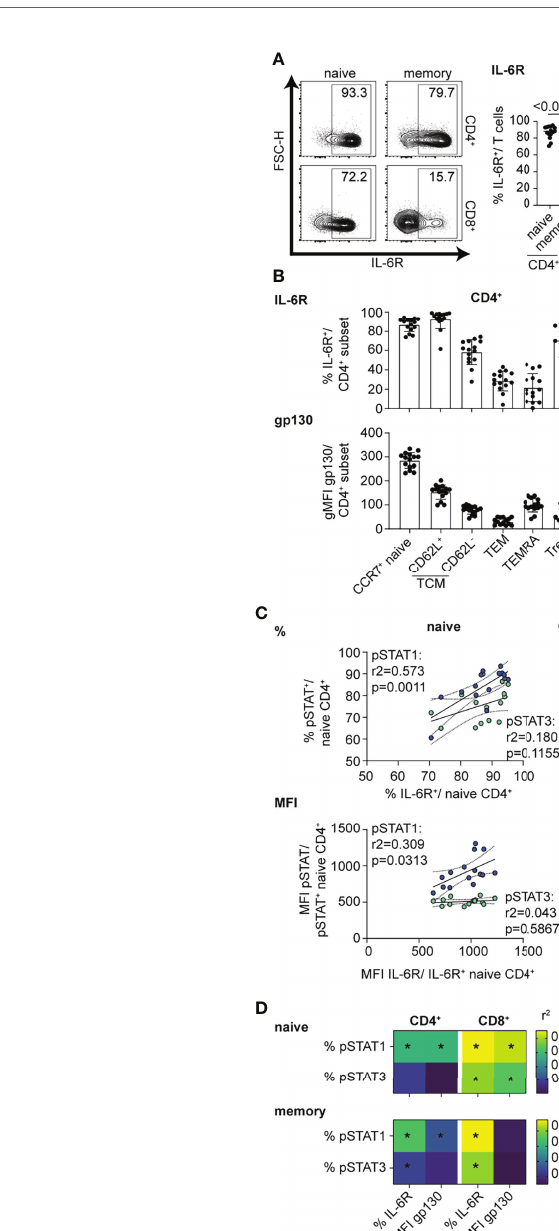
re fl ected in the transcriptome signature. We performed RNA-seq on sorted CD4 + naïve and memory T cells, as well as CD8 + naïve